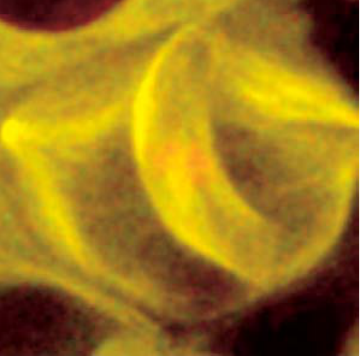
Figure 5. Chromosome Segregation in Anastral Spindles in Drosophila Spermatocytes (Control [Video 5]) At metaphase I (0), the bivalents (revealed by a His2Avd–YFP fusion, shown by double arrowheads) are aligned in the middle of the spindle (revealed by a GFP– a -tubulin fusion), at the metaphase plate. At the onset of anaphase (3 min), the homologue chromosomes start to migrate towards opposite poles (single arrow- heads) and to decondense. During anaphase B (4 min and 6 min), the spindle poles move apart from each other and the two sets of decondensed chromosomes become further separated. ( asp [Video 6]) At timepoint 0, the bivalents align at the metaphase plate. Homologue chromosomes split apart at the onset of anaphase I (4 min). However, anaphase A migration is highly impaired. By the time the chromosomes start to decondense, they have barely moved towards the spindle poles (8 min and 14 min), and often homologue chromosomes end up included in the same daughter nucleus. (Colcemid [Video 8]) As in asp spermatocytes, the asters (arrows) remain at the plasma membrane at metaphase I in colcemid-treated cells, and the bivalents align in a metaphase plate-like within the acentrosomal spindles (0 min). Homologue chromosomes split apart at the onset of anaphase (upper cell, 6 min) and significantly segregate from one another (upper cell, 8 min; lower cell, 3 min). Further separation of the daughter nuclei during anaphase B is very limited in these cells (8 min), and cytokinesis does not